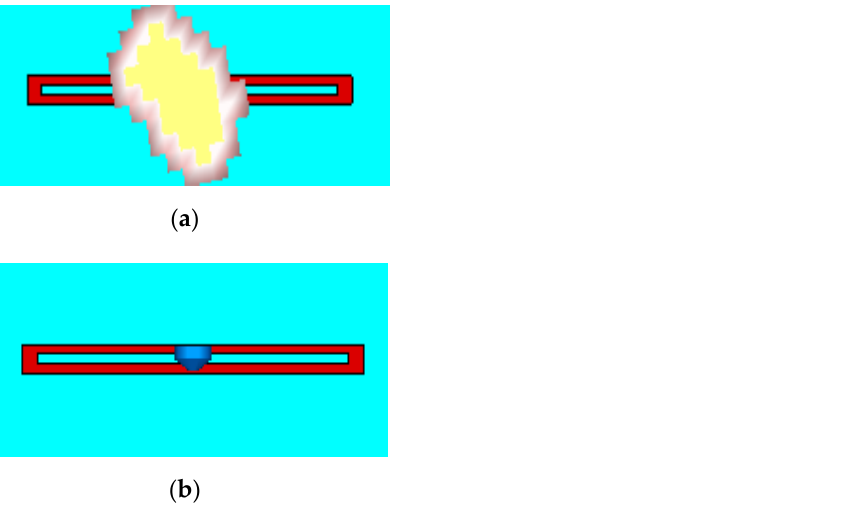
Figure 8. Simulation Structure corresponding to: ( a ) finger touch (only the fingertip was consid- ered in the simulation); ( b ) lumped capacitor in loop structure.